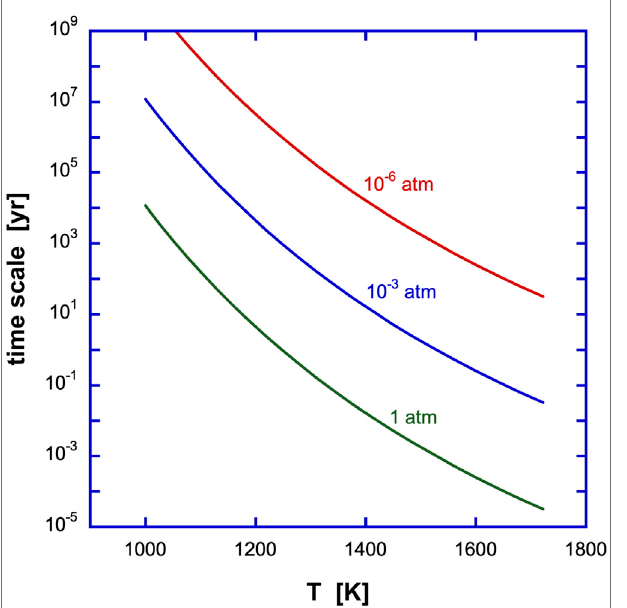
FIGURE 5 | Chemical timescale for the collisional dissociation of H 2 for three different pressures.